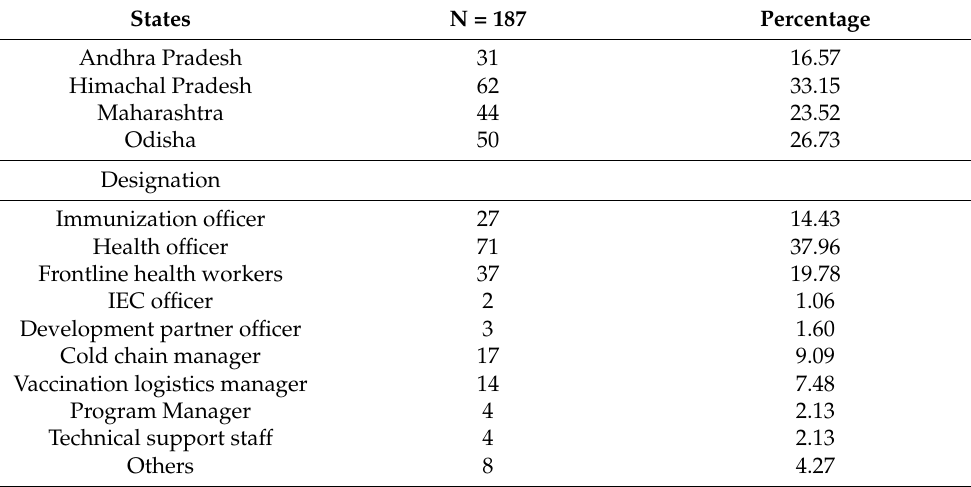
Table 2. Respondents’